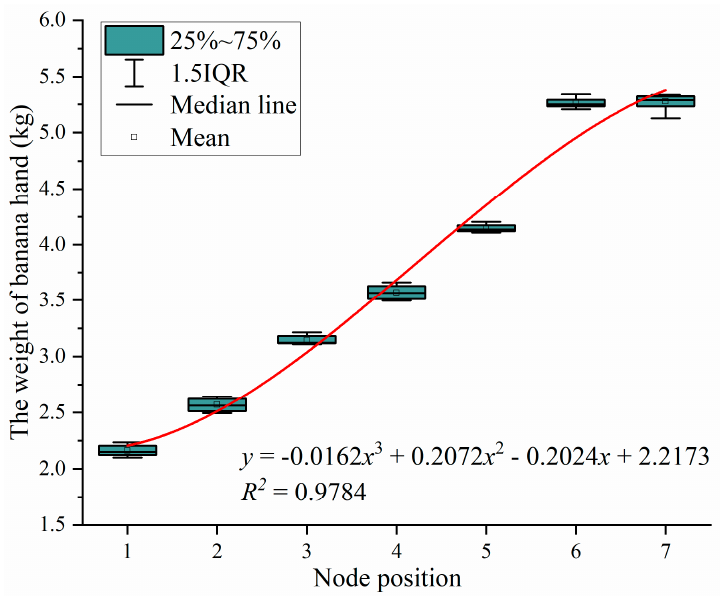
Figure 17. The relationship between the weight of banana hands and the node positions. Table 5. Table of regression coefficients of the weight of banana hands.